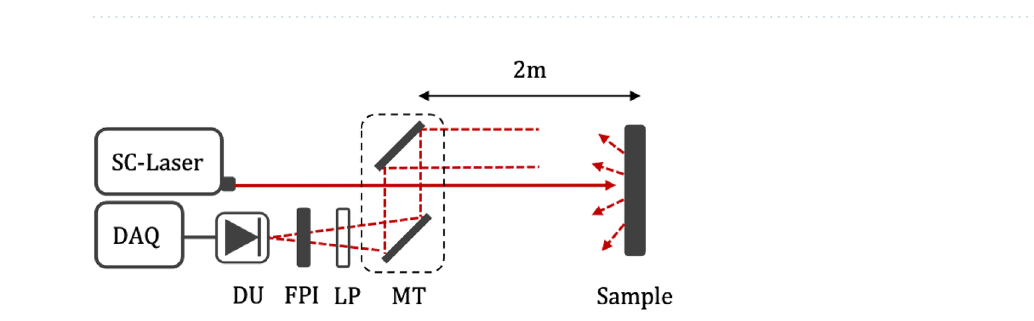
Figure 1. Tuning parameters of the Fabry-Pérot interferometer. ( a ) The blue line represents the corresponding central wavelength with respect to the tuning voltage, and the overlay red (dashed) line shows the full-width- half-maximum (FWHM). ( b ) Transmittance spectra of the Fabry-Pérot interferometer are shown as a function of the operating voltage in the range of 11–29 V with constant voltage increments indicated by different colors in the figure.